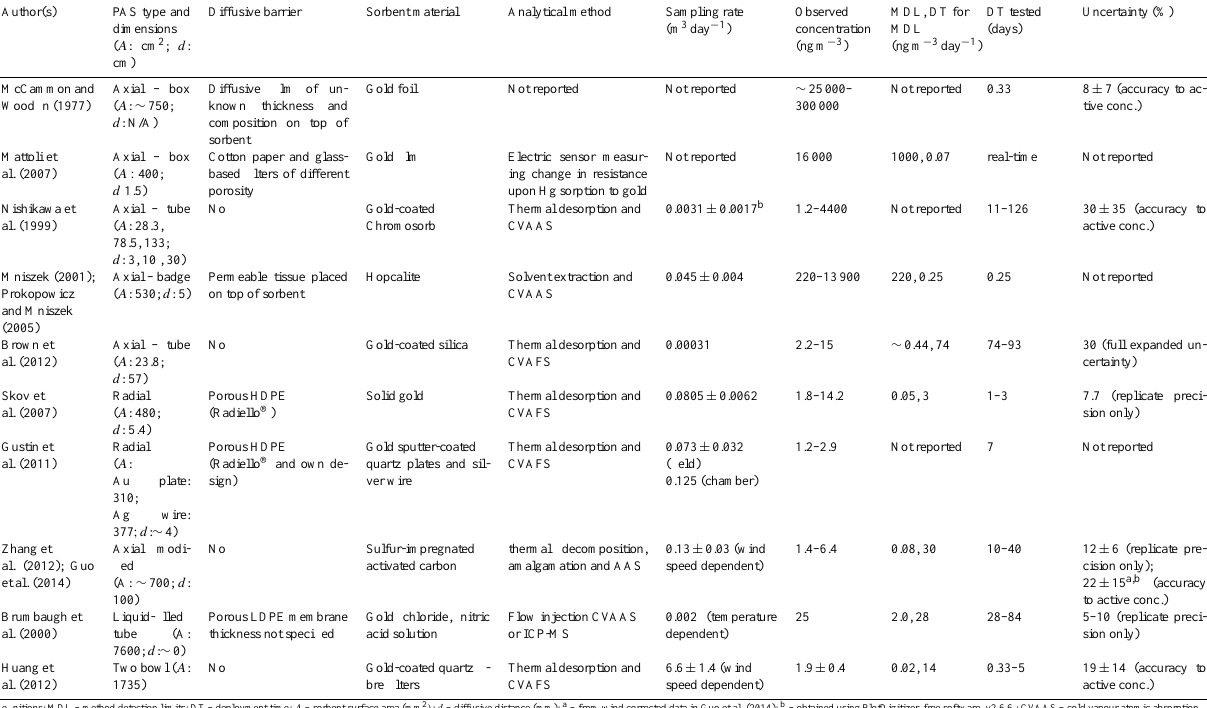
Table 1. Performance of PASs for GEM from published studies. Variability associated with environmental factors was not included as the majority of studies lacked this